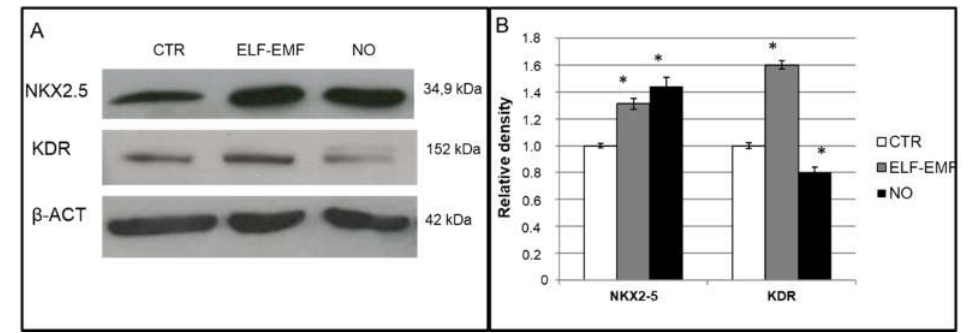
Figure 4. Cardio‐angiogenic commitment of hAMSCs by Western Blot analysis: ( A ) study of the protein expression of control cells (CTR), of 5 days 7 Hz, 2.5 μT exposed cells (ELF‐EMF) and cells treated with 0.4 mM of Nitric Oxide (NO); ( B ) semi‐quantitative analysis by VersaDoc using Quantity One software. Data are shown as mean ± SD. Asterisks identify statistical significance referring to the control sample ( p < 0.05) ( n = 3). Int. J. Mol. Sci. 2018 , 19 , x FOR PEER REVIEW